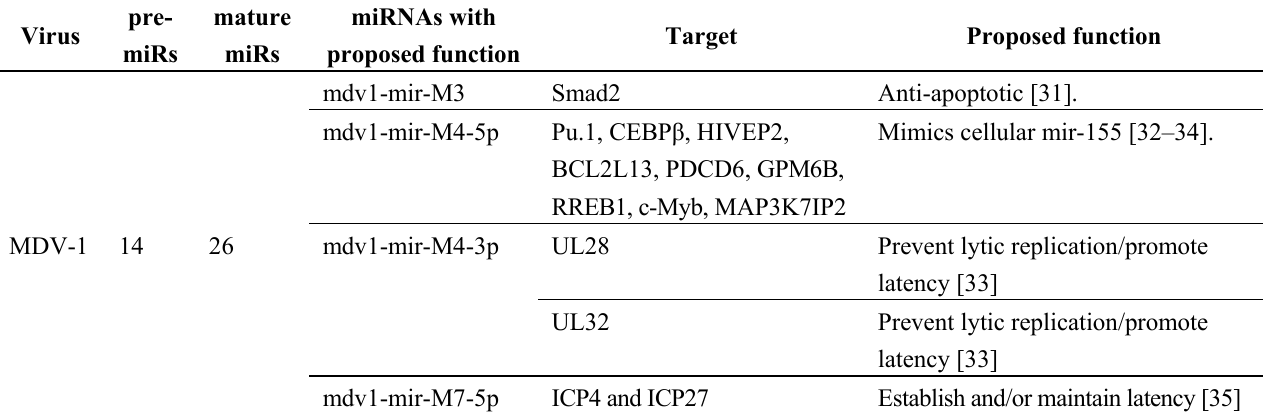
Table 1. Avian virus encoded miRNAs and proposed functions highlighted in this